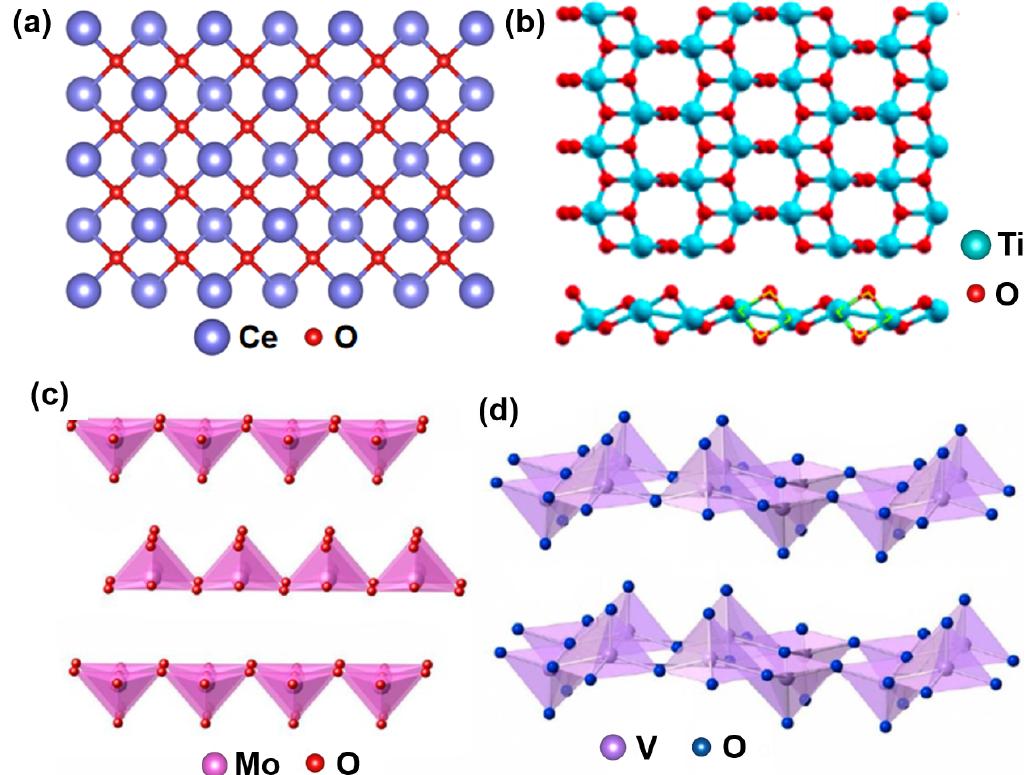
Figure 4. Crystal structures of ( a ) CeO 2 . ( b ) TiO 2 . Reproduced with permission from reference [101]. Copyright 2017, American Chemical Society. ( c ) MoO 3 and ( d ) α -V 2 O 5 . Reproduced with permission from reference [102]. Copyright 2015,